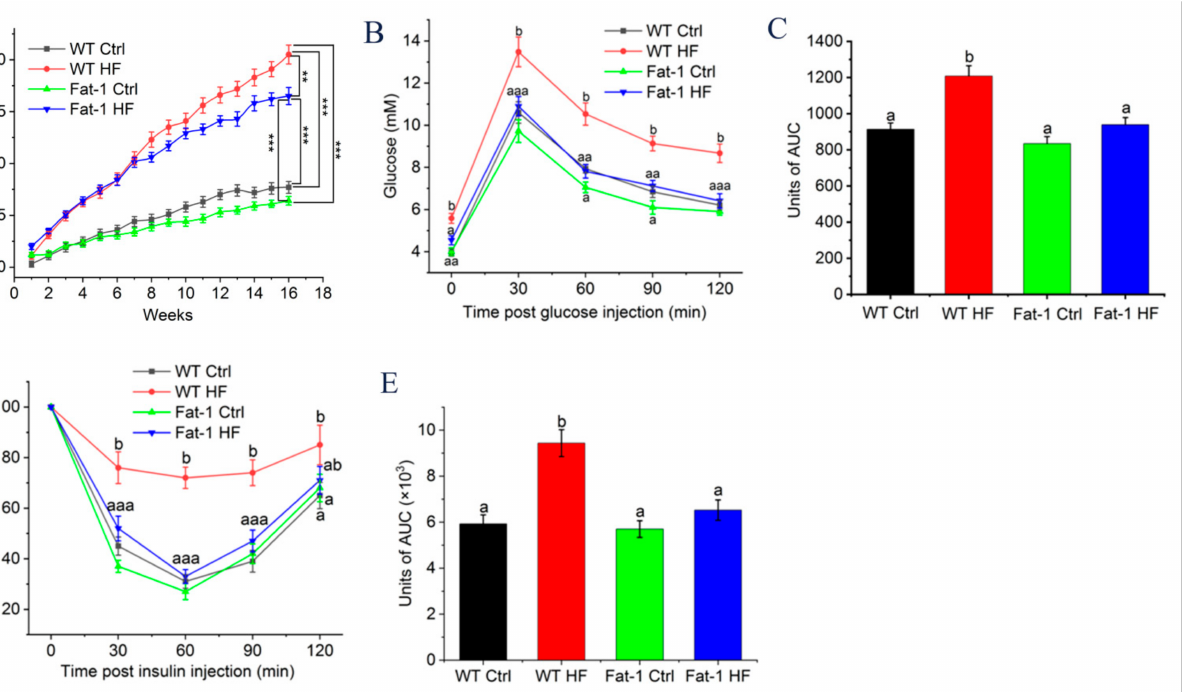
Figure 1. Less weight gain and improved glucose tolerance and insulin sensitivity, and lowered hyperglycemia levels were shown in HF diet-fed fat-1 mice: ( A ) Effects of endogenous n-3 PUFAs on body weight gain ( n = 8); ( B ) OGTT was performed in fasted WT and fat-1 transgenic animals ( n = 5); ( C ) Area under the curve (AUC) of the mean glucose levels after OGTT; ( D ) ITT was performed and normalized for base blood glucose in fasted animals ( n = 5); ( E ) The total area under the curve (AUC). ** p < 0.01 and *** p < 0.001. Means not sharing a common superscript letter are significantly different at p < 0.05. In addition, because there was little difference in glucose level among group WT Ctrl, Fat-1 Ctrl and Fat-1 HF in 30 and 120 min after glucose injection in ( B ), so superscript letter of these three groups was labelled together such as aaa, which means no significant difference among group WT Ctrl, Fat-1 Ctrl and Fat-1 HF, and so on aa is similar to aaa. WT Ctrl, WT mice fed a control diet; WT HF, WT mice fed a high-fat diet; Fat-1 Ctrl, fat-1 mice fed a control diet; Fat-1HF, fat-1 mice fed a high-fat